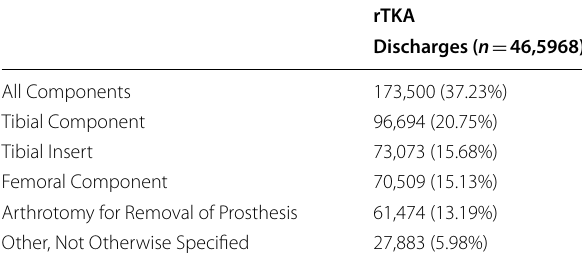
Table 4 Types of rTKA collected from the NIS database from